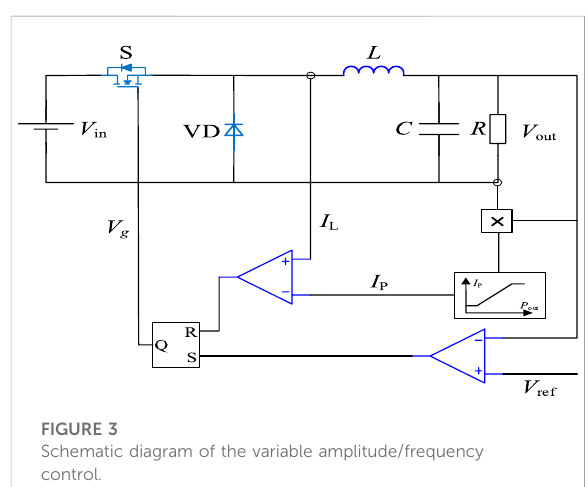
Schematic diagram of the variable amplitude/frequency